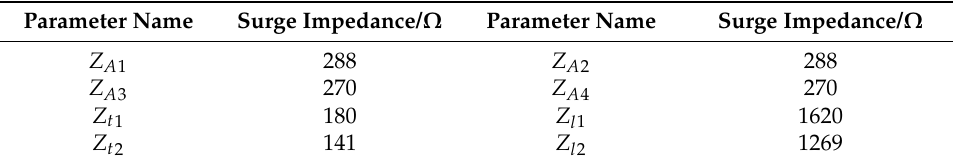
Table 2. Parameters for the multi-surge impedance model.